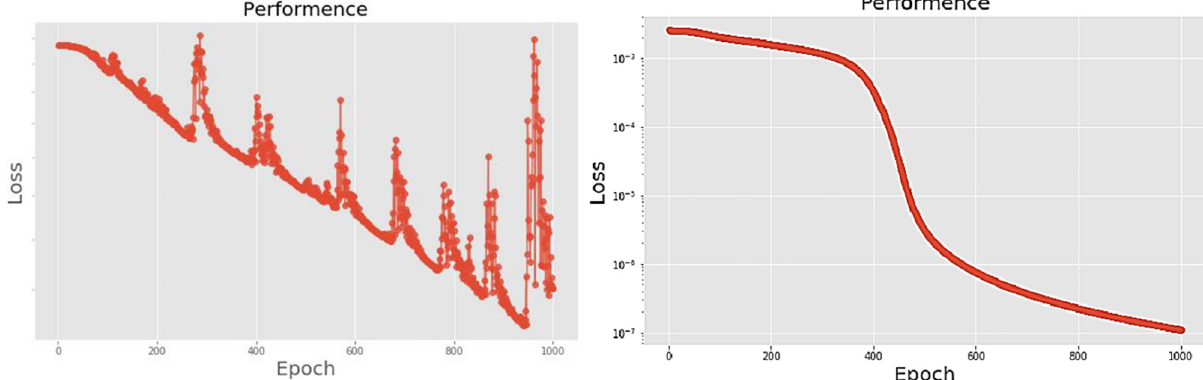
Fig 16. (a) The graph shows the performance of LPC-DNN-24-layer model; (b) The graph shows the performance of LPC-PCA-DNN-24-layer